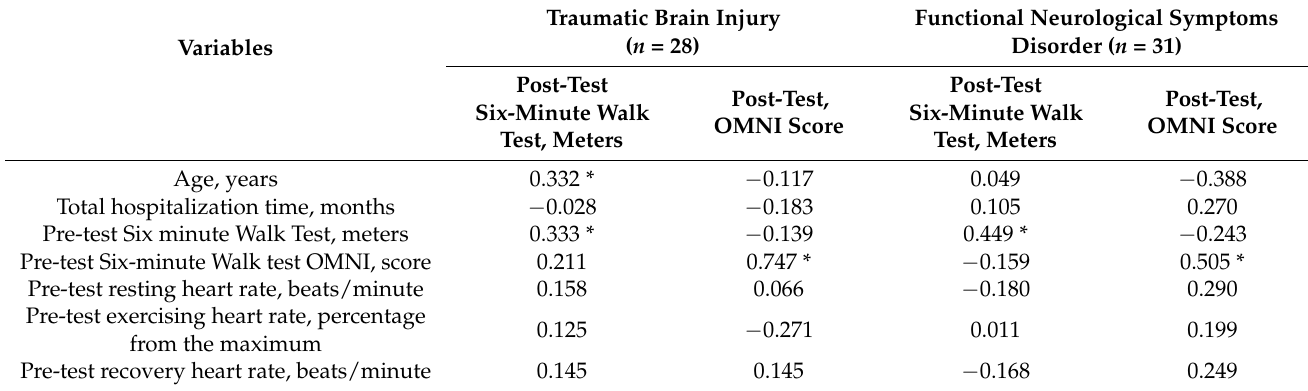
Table 2. Associations with walking ability and rate of perceived exertion post-test.